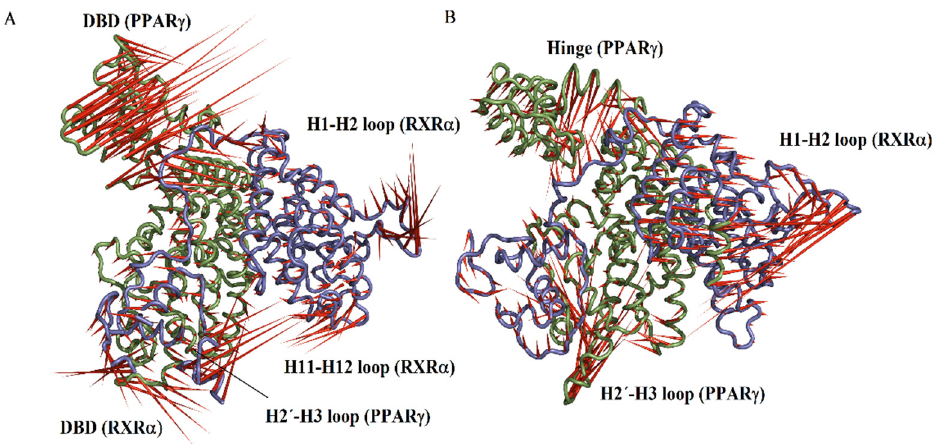
Figure 7. Graphic representation of the projection on PPAR γ -RXR α and PPAR γ -RXR α -DNA systems. Graphical depiction of the two extreme projections along PC1 vs. PC2 for the PPAR γ -RXR α ( A ) and PPAR γ -RXR α -DNA ( B ) systems. The direction and magnitude of movements are described as porcupine drawings.